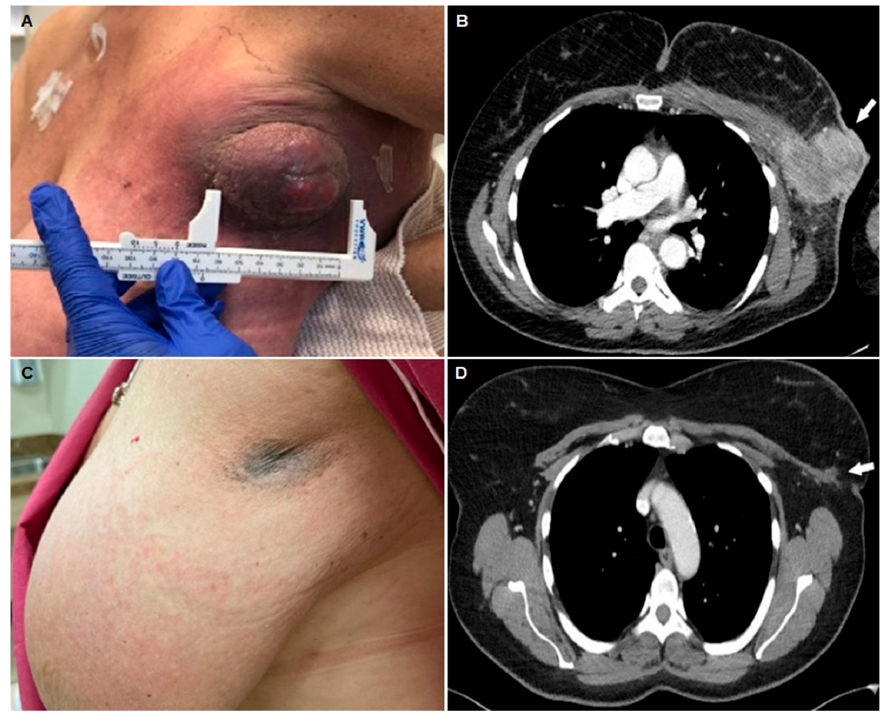
Figure 1. Neoadjuvant pembrolizumab and chemotherapy induced clinical response in a triple- negative IBC patient. A small boil-like left axillary mass increased in size in six weeks with associated pain, swelling, and erythema ( A ). Chest computerized tomography (CT) indicated the presence of a large left fungating mass in the lateral left breast (7.7 × 5.7 cm) with associated left sub-pectoral, axillary, and internal mammary lymphadenopathy and diffuse edema and skin thickening within the left breast with skin involvement (white arrow) ( B ). The fungating mass and left breast erythema were resolved after completion of the neoadjuvant pembrolizumab and chemotherapy ( C ); a post-treatment chest CT with contrast demonstrated a significant decrease in the size of the previously biopsied left axillary mass (white arrow) ( D ). Improvement in previously seen left axillary lymphadenopathy and dermal thickening of the left breast/axilla was also observed ( D ). Text and pictures ( A – D ) were modified from Kharel et al. [14], Breast Disease (2022); 41:255–260, with permission from IOS